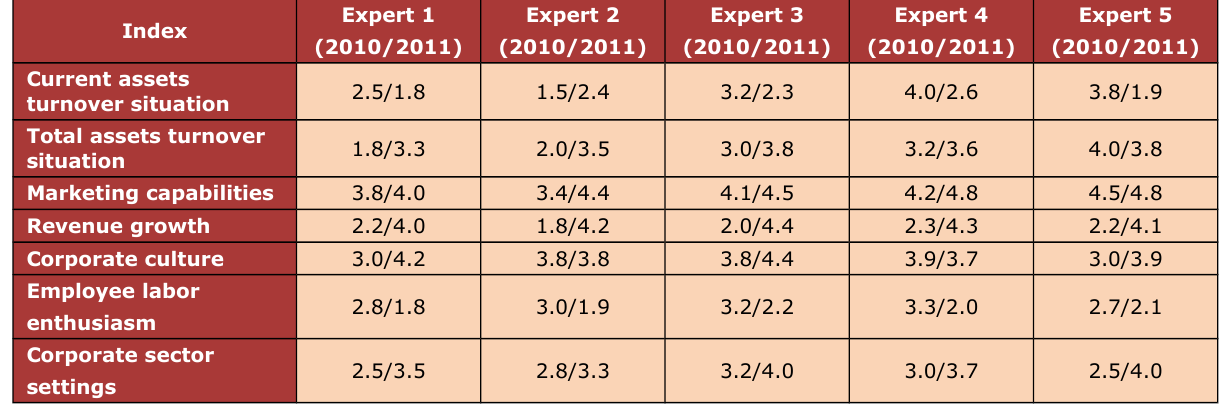
Table 2. Indexes scores in 2010/2011 (Enterprise